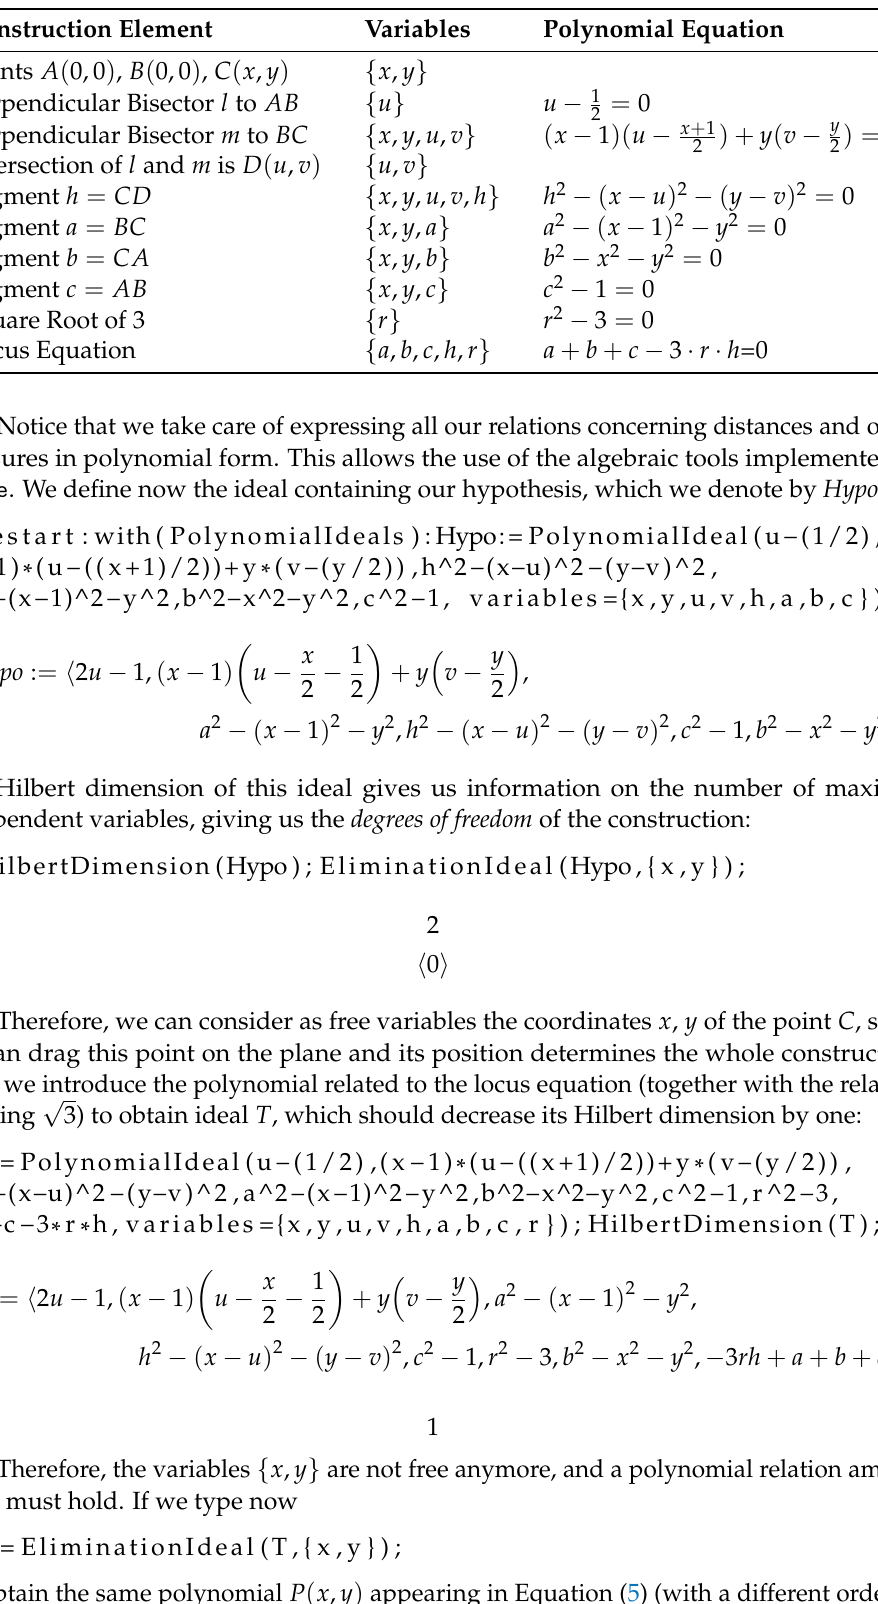
Table 1. Algebraic translation of geometric construction in